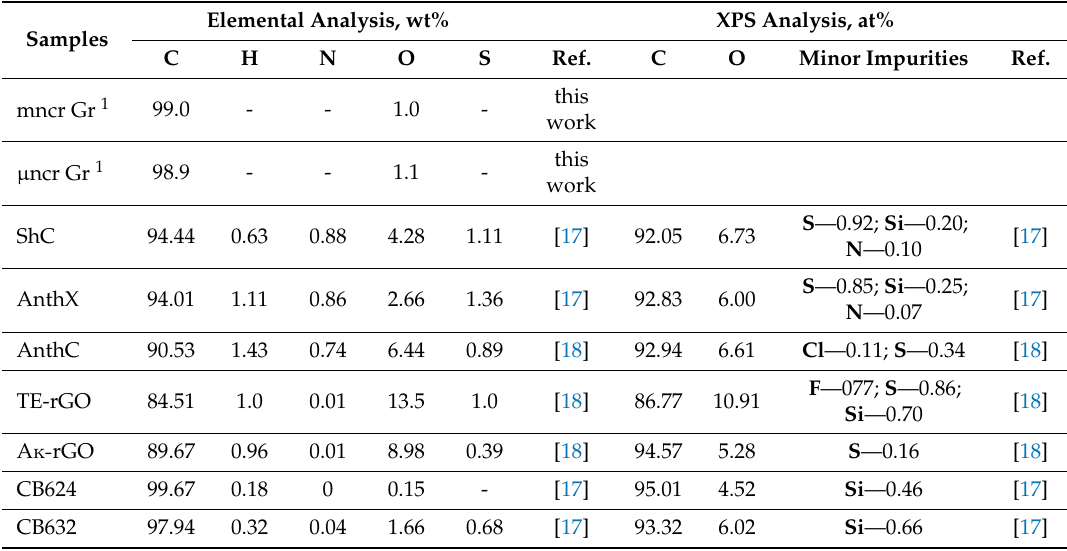
Table 2. Chemical content of amorphous